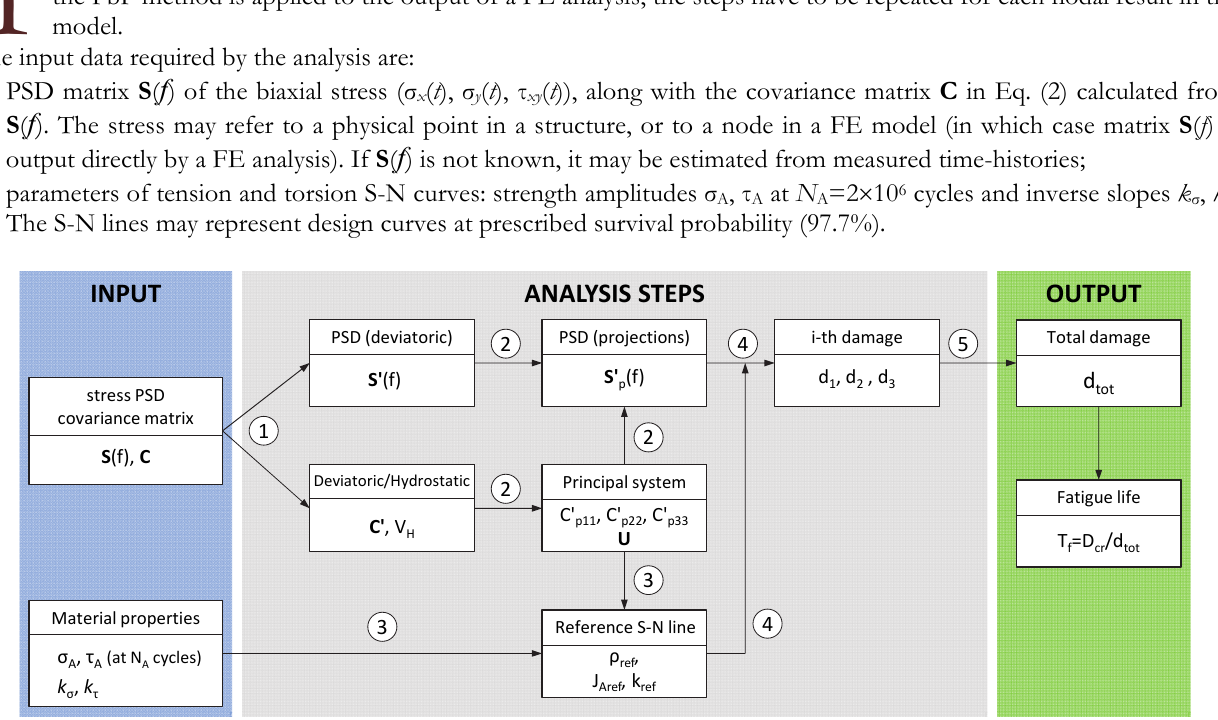
Figure 1: Analysis steps and quantities involved by the PbP spectral method in